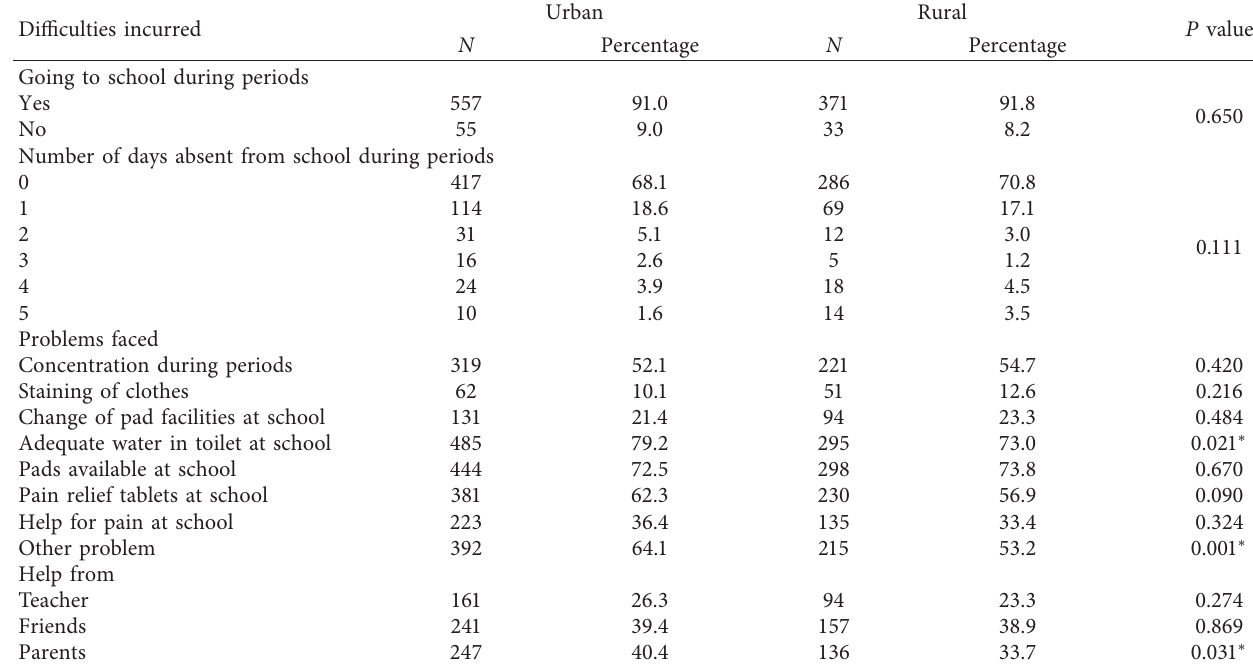
Table 4: Difficulties incurred by the participants at school during menstruation by the place of